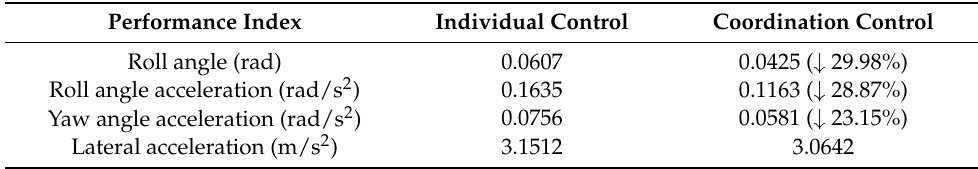
Table 4. RMS values of the performance indexes under step